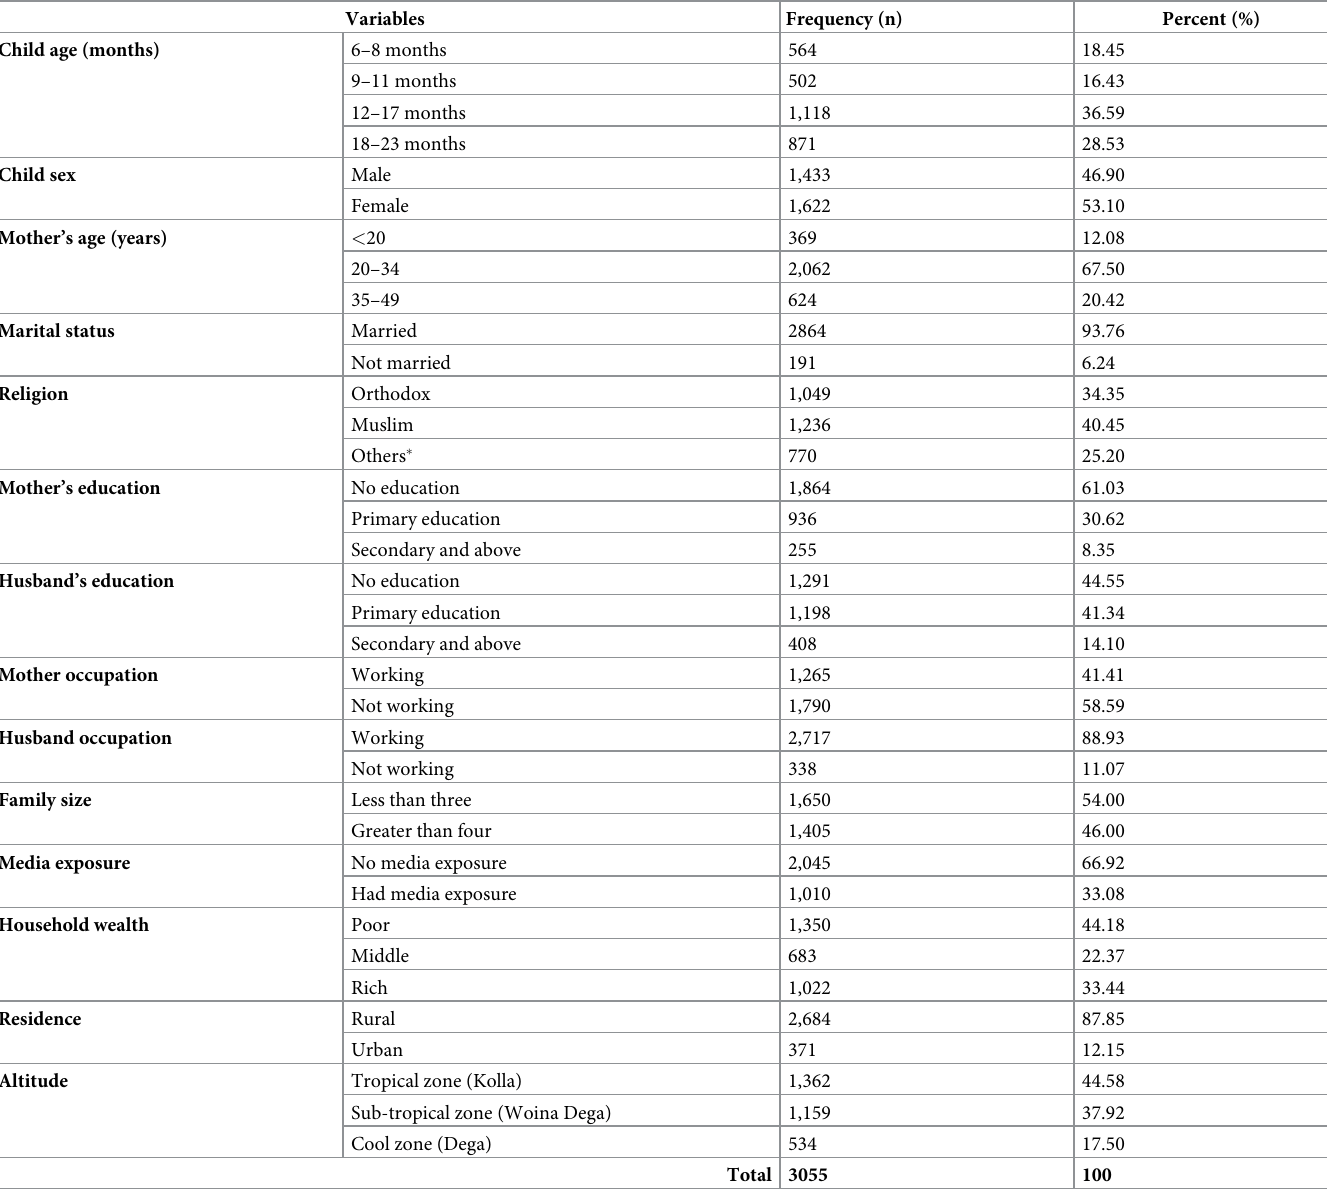
Table 1. Sociodemographic characteristics of the respondents and study children aged 6–23 months in Ethiopia, EDHS 2016 (n = 3055).